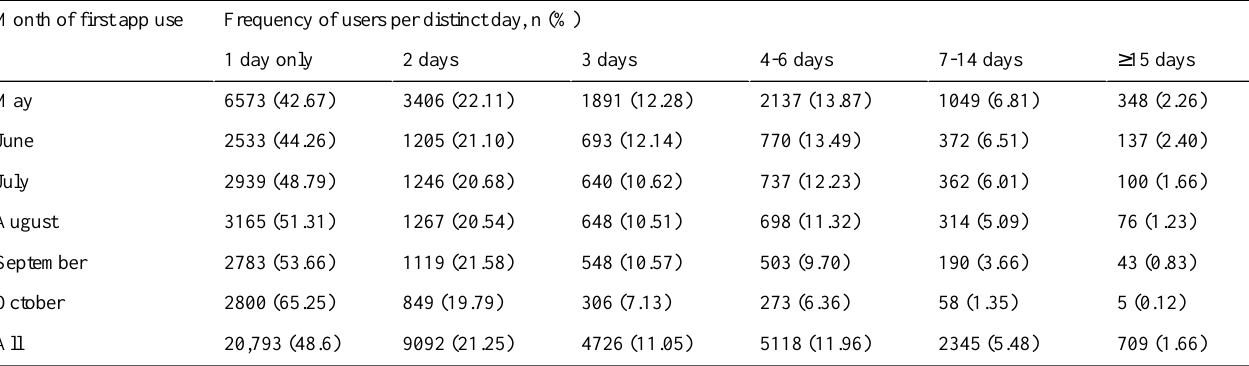
Table 3. Total number of distinct days of COVID Coach use, by month of first app use. Frequency of users per distinct day, n (%)Month of first app use